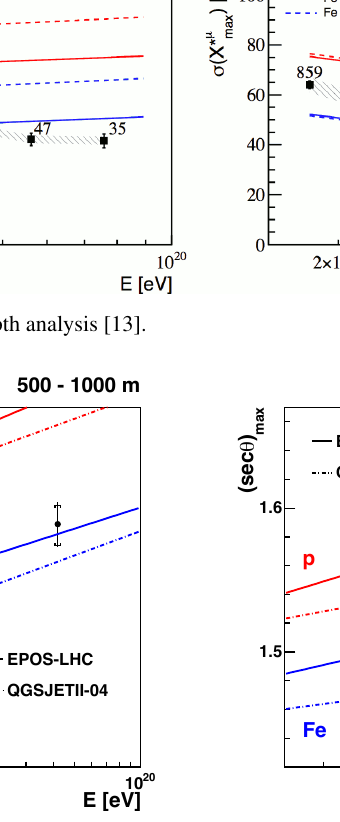
Figure 4. Results of the azimuthal asymmetry analysis of risetime